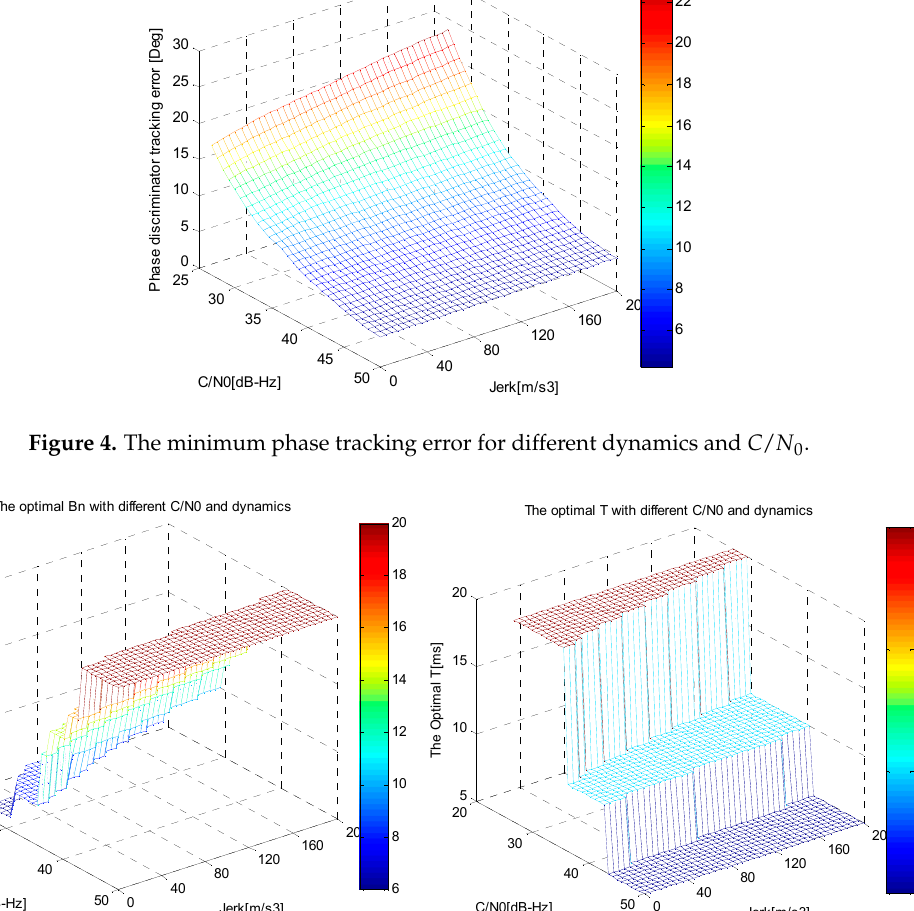
Figure 5. Optimal choices of B n ( left ) and T ( right ) for different dynamic and C / N 0 .